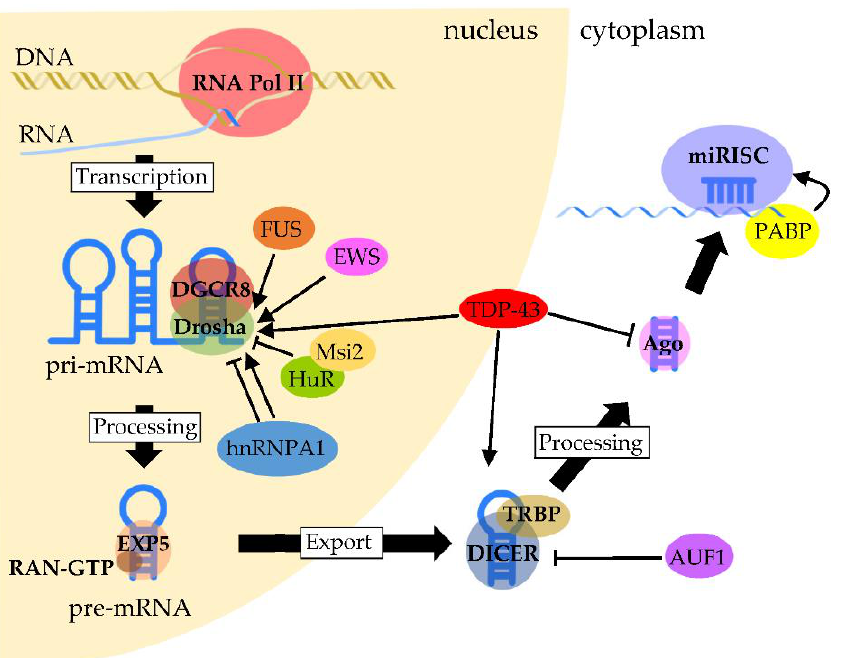
Figure 1. Regulation of RBPs in miRNA biogenesis and processing. Pri-miRNAs are transcribed mainly by RNA polymerase II. The processing of pri-miRNA is mediated by a complex formed between Drosha and DGCR8, called Microprocessor, to generate pre-miRNA. TDP-43 facilitates the association of the Drosha complex with pri-miRNAs, whereas FUS and EWS promote Drosha recruitment to chromatin. HuR-mediated Msi2 binding to pri-miRNA inhibits Drosha cleavage. The function of hnRNP A1 is complexed, since it contributes to either the inhibition or stimulation of processing, which depends on the pri-miRNA. After pre-miRNAs are exported through the binding of Exportin-5 with RAN-GTP, pre-miRNAs are processed by Dicer. The processing of pre-miRNAs is facilitated by TDP-43 through the binding of Dicer with pre-miRNAs, whereas Dicer expression is negatively regulated by AUF1. On the other hand, TDP-43 negatively regulates the formation of miRISC from the Ago protein. PABP binds to the poly(A) region of target mRNA and promotes miRISC recruitment.